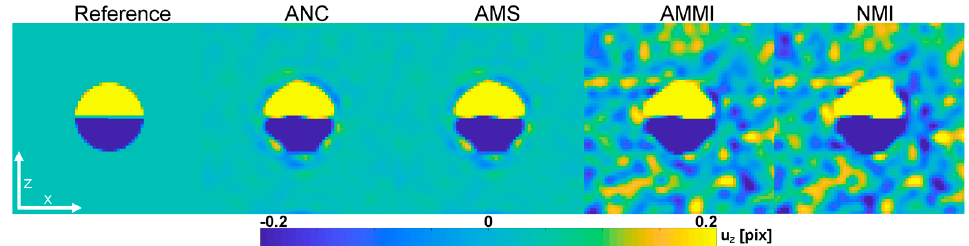
Figure A1. Representation of the reference displacement field (manufactured solution) and the displacement field as recovered by Elastix, with various definitions of the similarity metric. Reference illustrates the exact displacement field, i.e., the manufactured solution, while ANC, AMS, AMMI and NMI correspond to different metrics used in the DVC code Elastix.